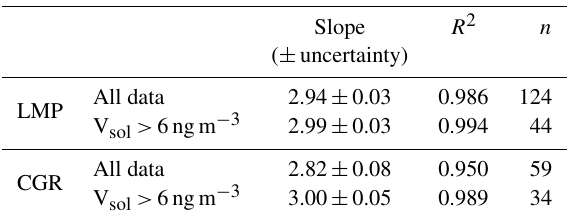
Table 3. Correlation parameters between V and Ni at LMP and CGR calculated for all the samples, and for samples with V con- centration higher than 6ngm − 3